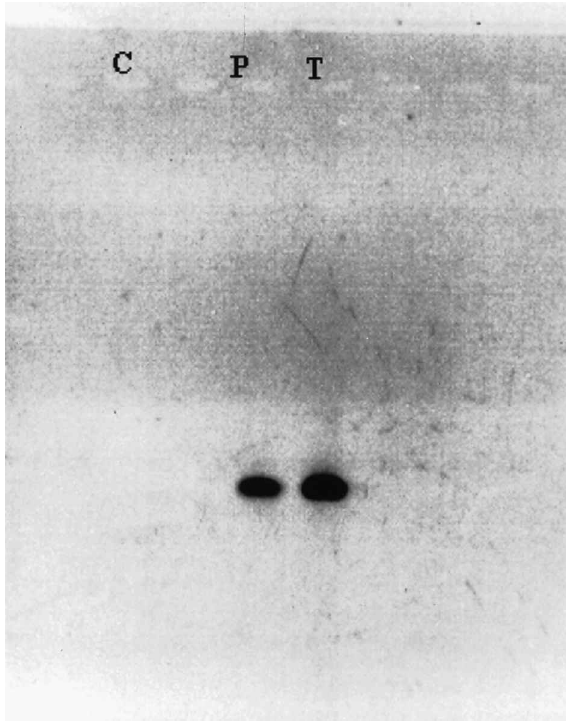
FIG. 1. SLPI cDNA fragments were demonstrated in pan- creatic tissue using RT-PCR and Southern blot. C, negative control containing water; P, pancreatic tissue; T, tracheal tissue used as a positive control. In the lane representing pancreatic tissue strong specific staining of the correspond- ing amplified cDNA fragments was observed. The band is at the same position but somewhat weaker than that for the positive tracheal control. No bands were detected in the lane containing the negative